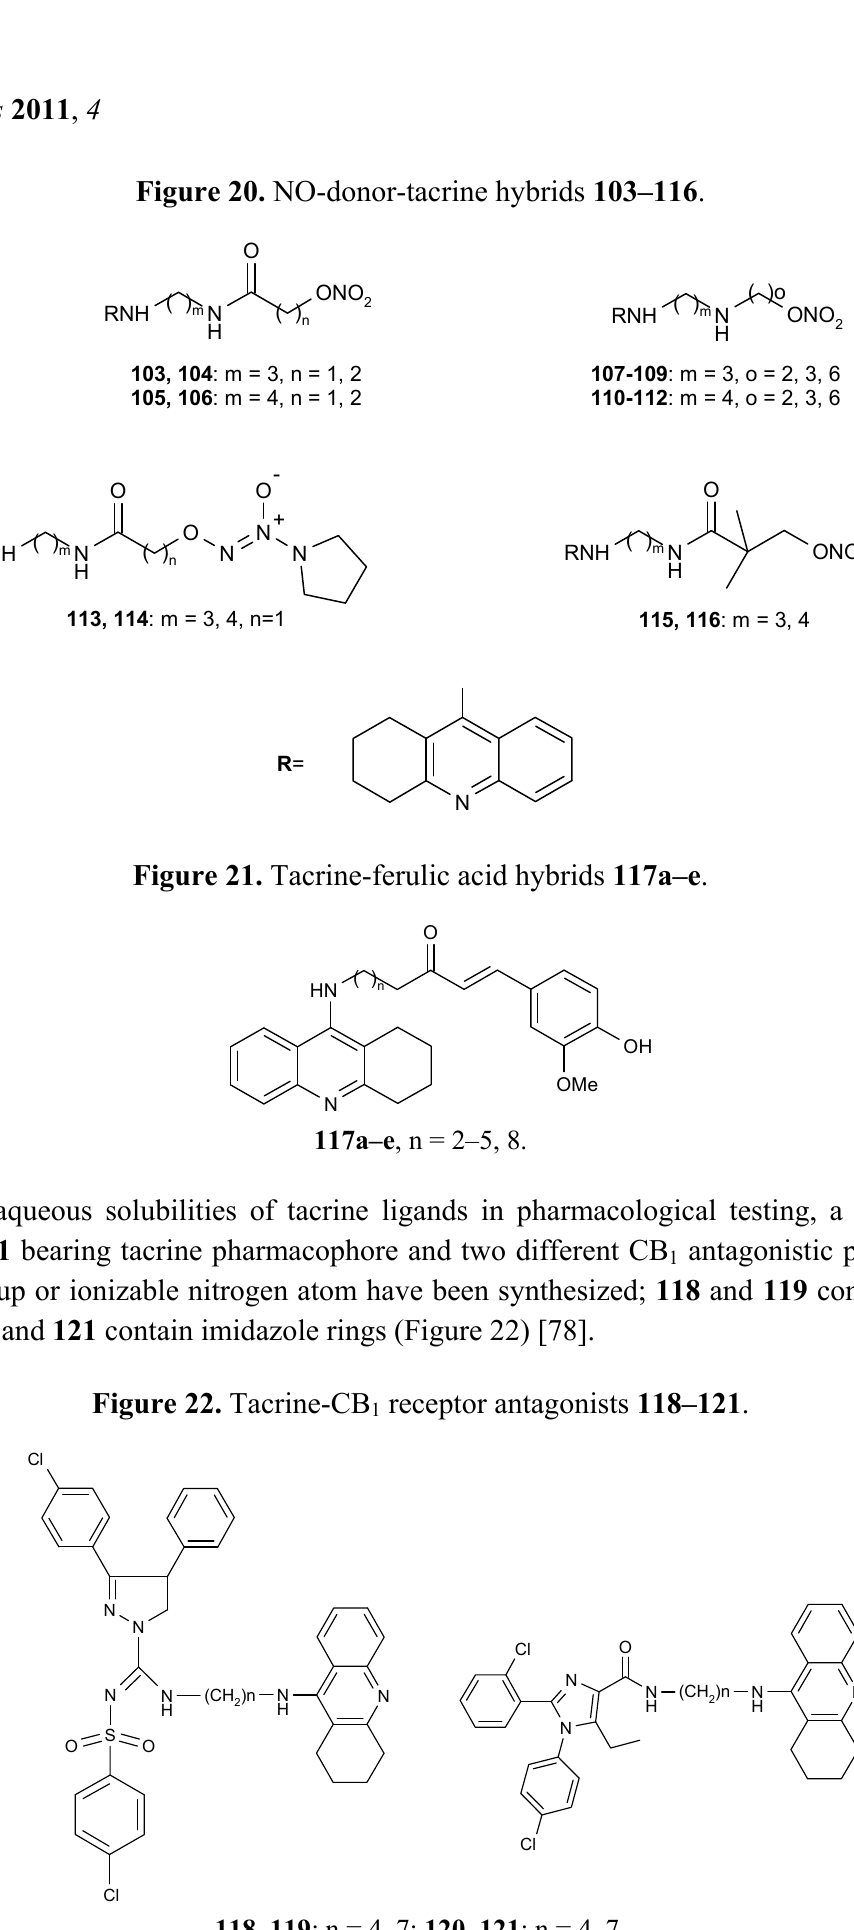
Figure 20. NO-donor-tacrine hybrids 103–116 .